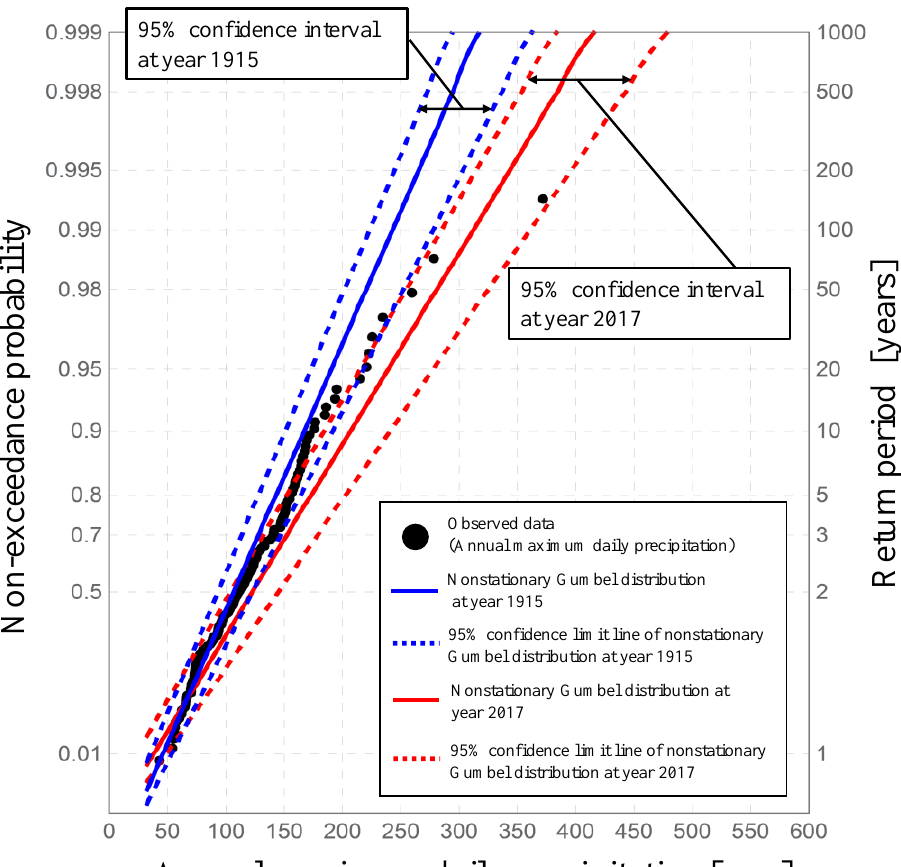
Figure 7. Observed data of the annual maximum daily precipitation over 142 years (from 1876 to 2017. at the ground observation station Tokyo, together with the non-stationary Gumbel distribution fitted to these 142 observed data (blue solid line: non-stationary Gumbel distribution in 1915; red solid line, non-stationary Gumbel distribution in 2017), and the 95% confidence interval of both non-stationary Gumbel distributions based on probability limit method test. n is the total number of observed data. Note that the Hazen formula was used for the plotting position equation.